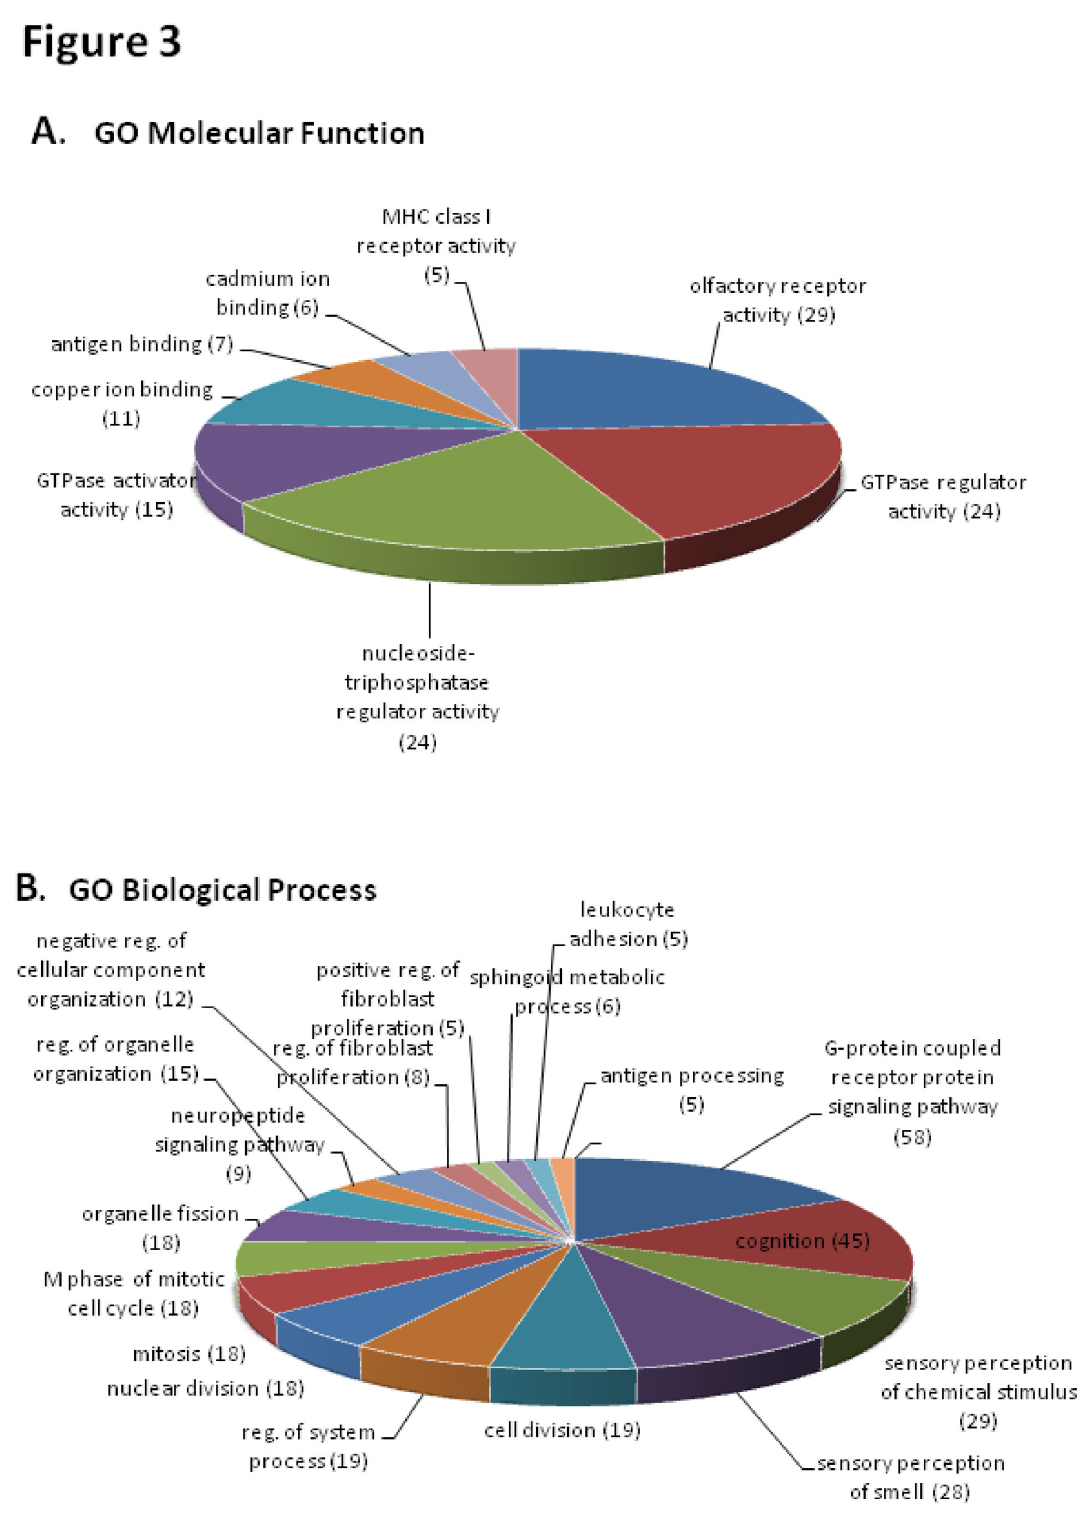
Figure 3. Over-represented Gene Ontology (GO) annotation among differentially expressed genes. GO categories identified using Database for Annotation, Visualization and Integrated Discovery (DAVID; http://david.abcc.ncifcrf.gov/). A ) Biological Process and B ) Molecular Function. doi: 10.1371/journal.pone.0084646.g003 PLOS ONE |